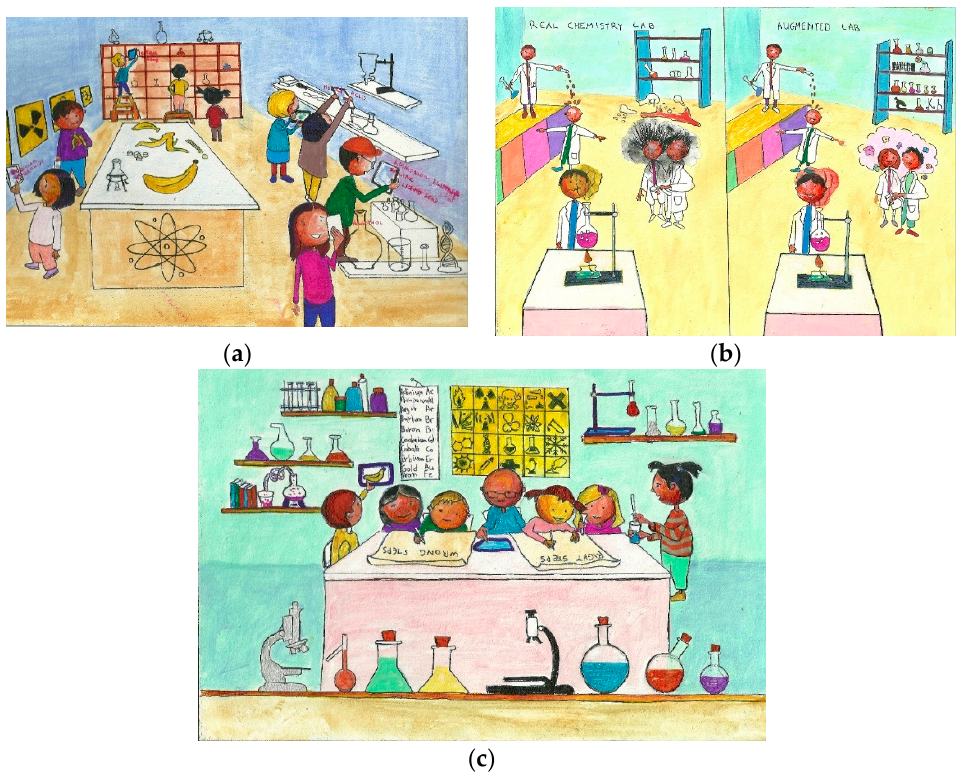
Figure 9. Clockwise: ( a ) Preparing for the experiment; ( b ) the experiment; and ( c ) discussing after the experiment (design: Christoforakis and Chrysoglou).